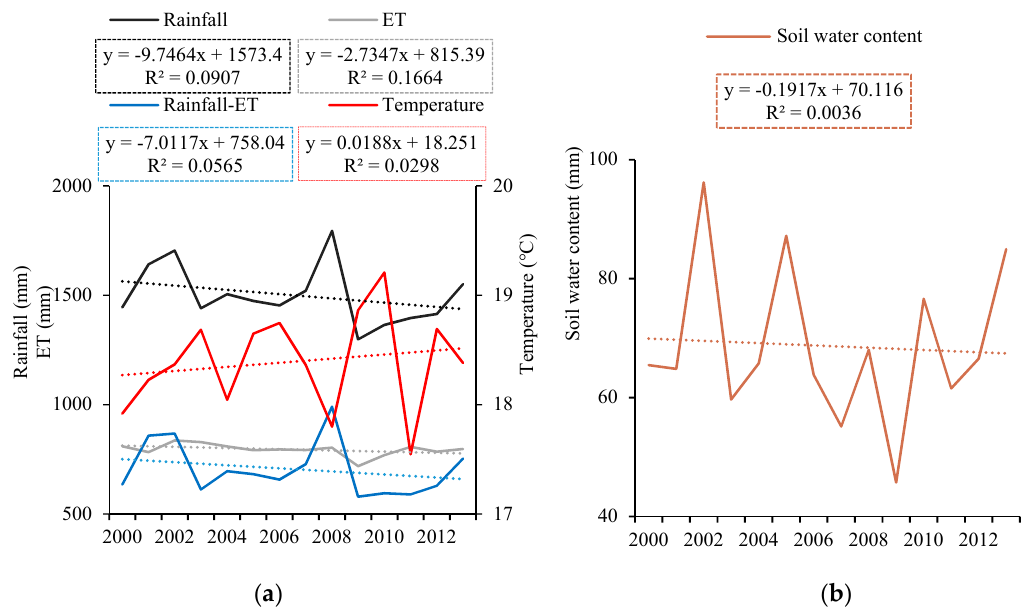
Figure 5. ( a ) Annual rainfall (black solid line), actual evapotranspiration (ET) (gray solid line) and temperature (red solid line) of the whole Red River basin from 2000 to 2013. Blue solid line is the di ff erence between rainfall and ET, which theoretically equals to available water. Black, gray, blue and red dash lines are the trendlines of rainfall, ET, the di ff erence between rainfall and ET, and temperature, respectively. Formulas in the black, gray, blue and red rectangles are the linear fit equations of rainfall, ET, the di ff erence between rainfall and ET, and temperature, respectively. ( b ) Mean annual soil water content (brown solid line) of the whole Red River basin from 2000 to 2013. Brown dash line is the trendline of soil water content, and formula in the black the linear fit equation of soil water content.